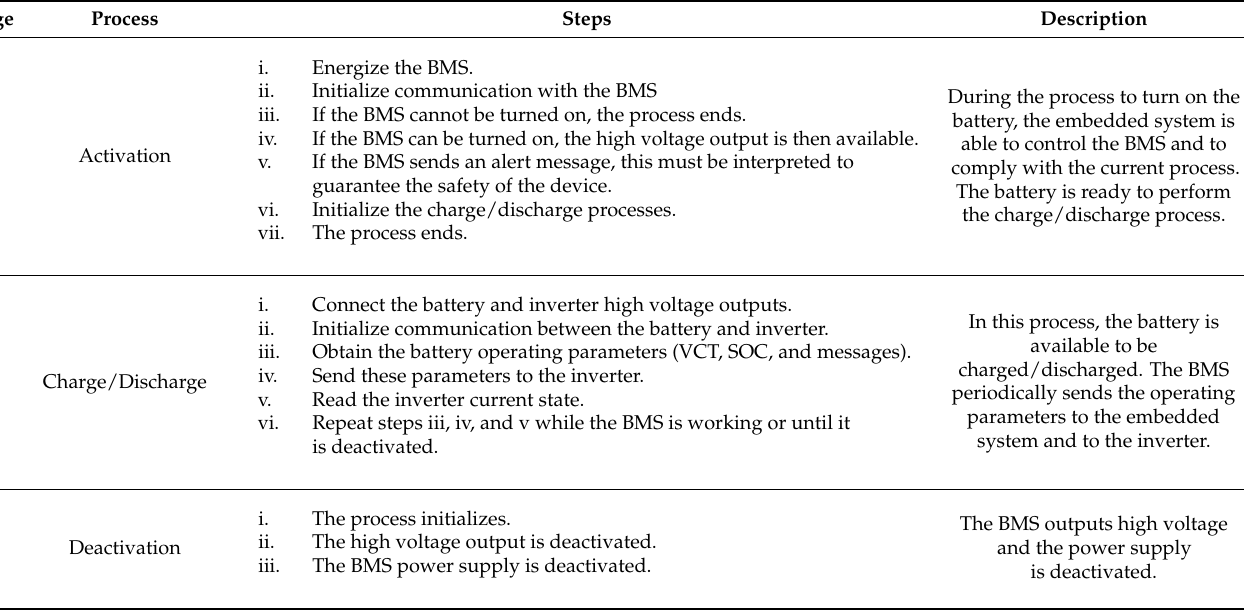
Table 2. Communication processes between the BMS and Li-ion